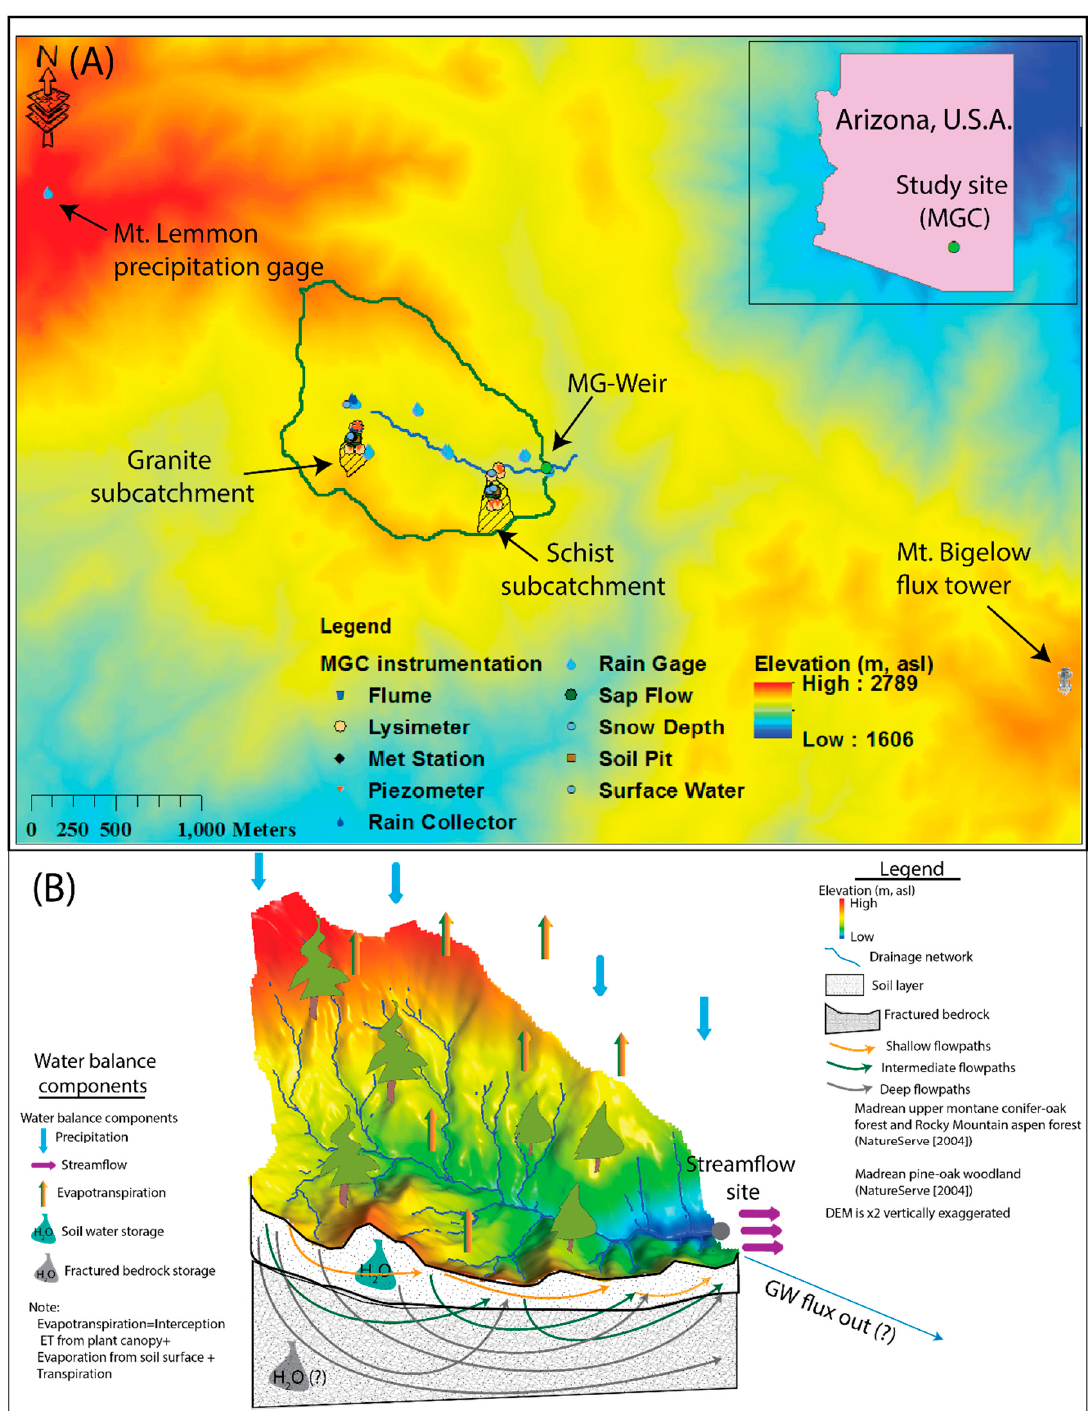
Figure 1. ( A ) The Marshall Gulch Catchment (MGC) field site (the catchment boundary is shown in green) showing existing instrumentation. Inset: Map of Arizona showing the location of the study site. Digital elevation model (DEM) is from [33] . ( B ) Schematic representation of three-dimensional flowpath structure at MGC with various water balance components. The symbol “?” in (B) suggests unknown total fractured bedrock storage at MGC.